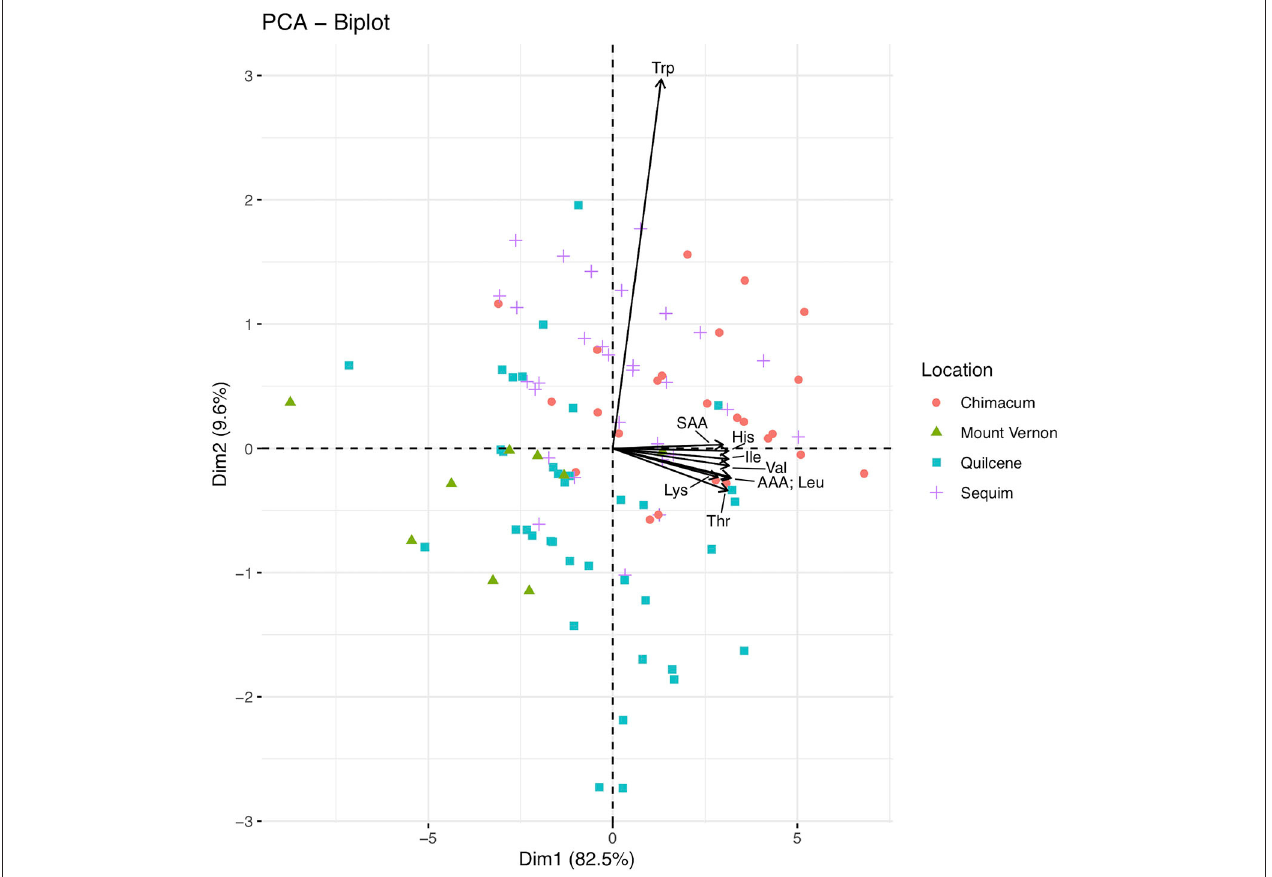
FIGURE 2 | Biplot for principal component analysis (PCA) of the essential amino acid dataset ( n = 100). Principal component one (i.e., Dim1; 82.5% of variance) and two (i.e., Dim2; 9.6% of variance) are plotted as the x- and y- axis, respectively. Essential amino acids are abbreviated using standard three letter abbreviations. The sulfur and amino acids (methionine and cysteine) aromatic amino acids (phenylalanine and tyrosine) are abbreviated as SAA and AAA, respectively. Points are color and shape coded by locations as shown in the figure